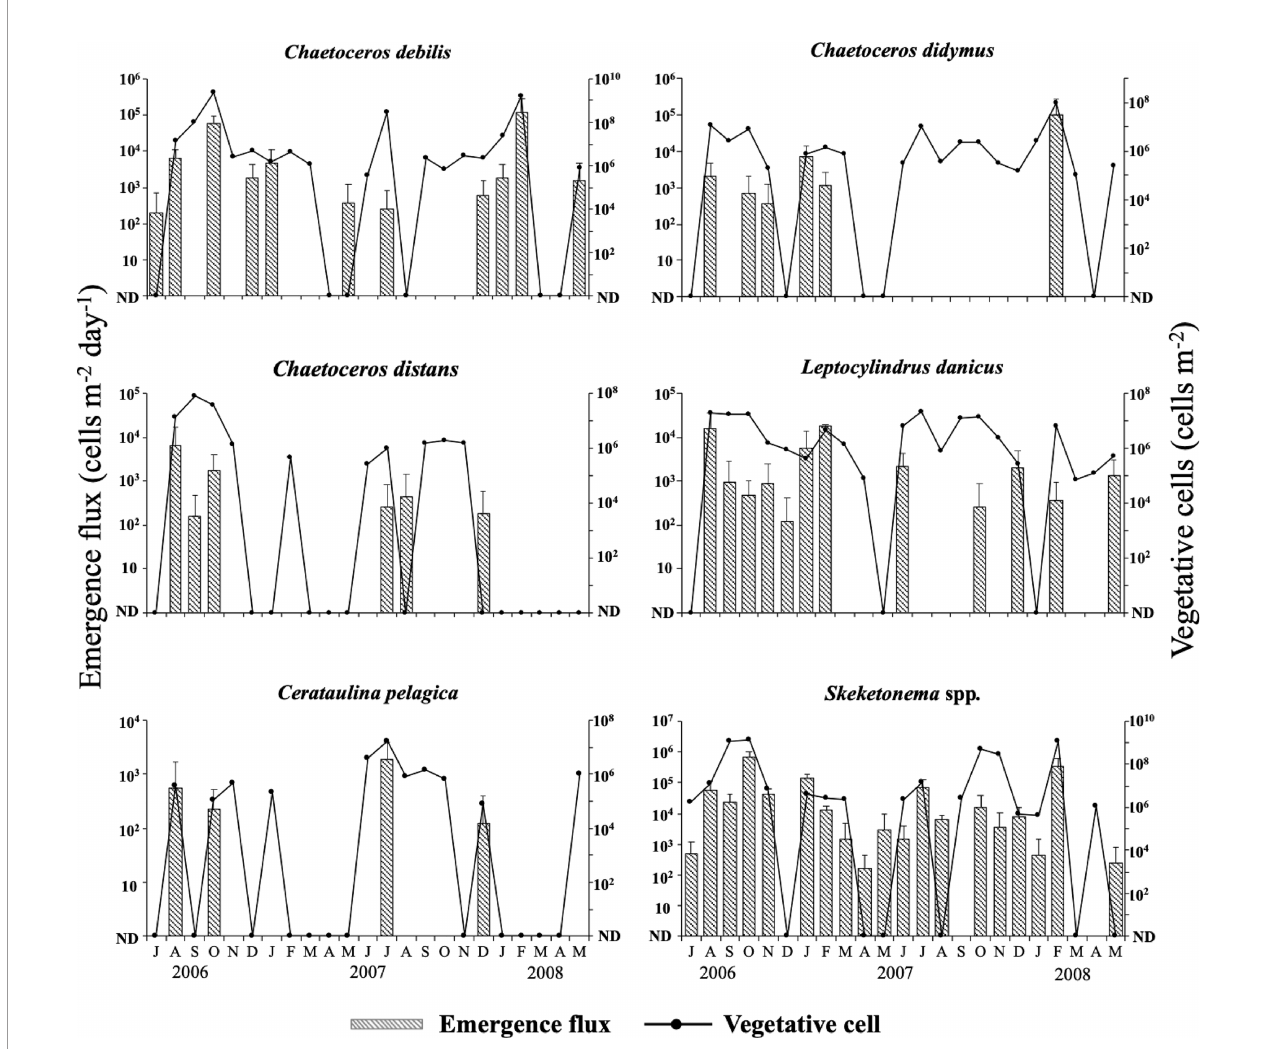
FIGURE 8 | Temporal changes in the integrated abundance of the vegetative cells in the water column and the emergence fl ux in the PET chamber for six diatom taxa at the sampling site in Ago Bay. ND denotes that the cells were not detected. Bars represent standard deviations (+SD).